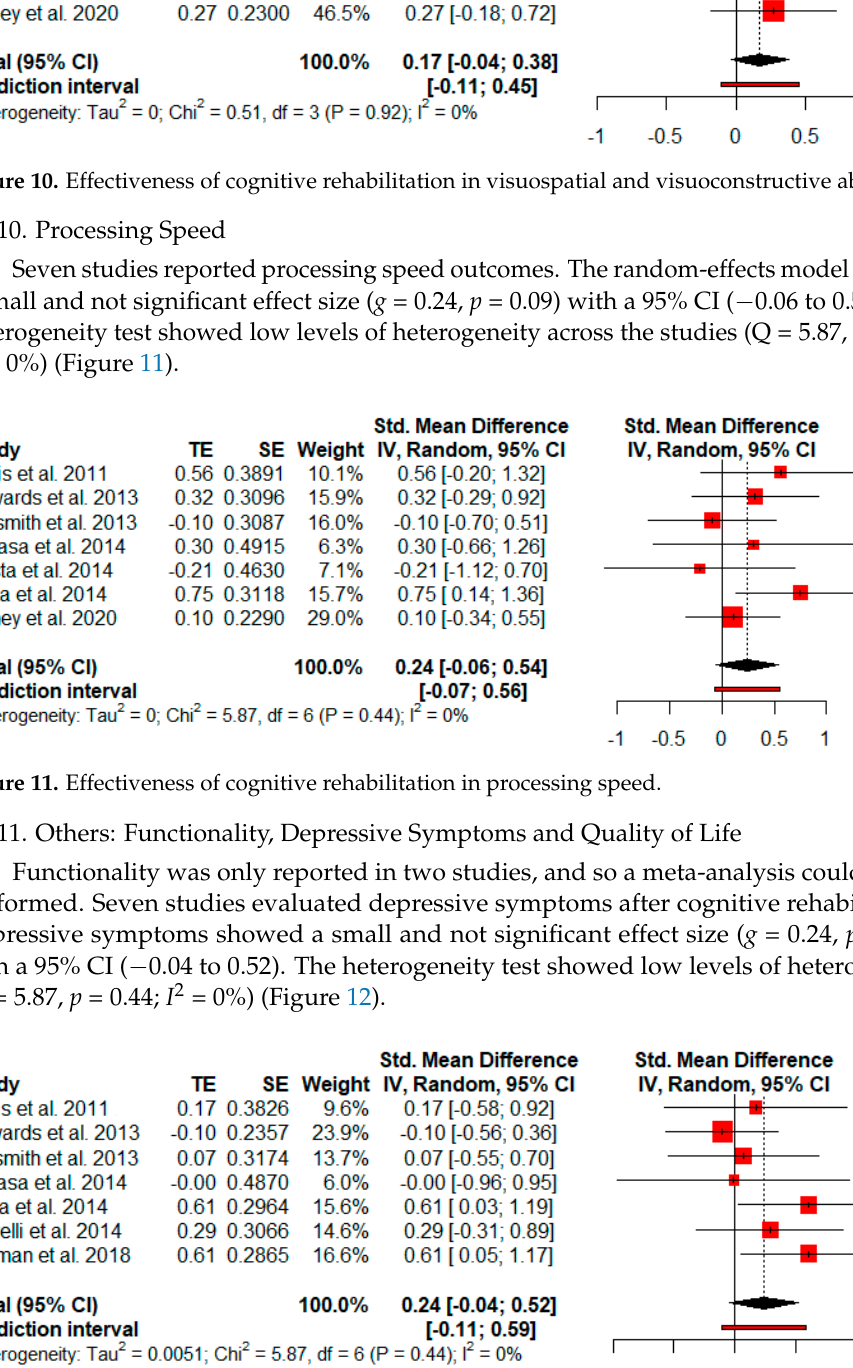
Figure 13 . Effectiveness of cognitive rehabilitation in quality of life. 3.4. Moderator Analyses Moderator analyses were performed to explore possible parameters that may explain the differences between the effect sizes obtained. The mixed-effects model meta-regres- sion analyses were conducted with the overall cognitive function effect sizes estimated as previously shown in Figure 2, and with the following predictor variables: participants’ age and years of education, variables related to intervention time (number, frequency, and duration of sessions), the modality of delivering the cognitive training (pencil and paper or computer), baseline global cognitive scores and PD patient-related features (disease duration, UPDRS III [26] and H&Y scale [27]) (See Table 2). Table 2 . Results of overall cognitive function meta-regression analyses. Model Number